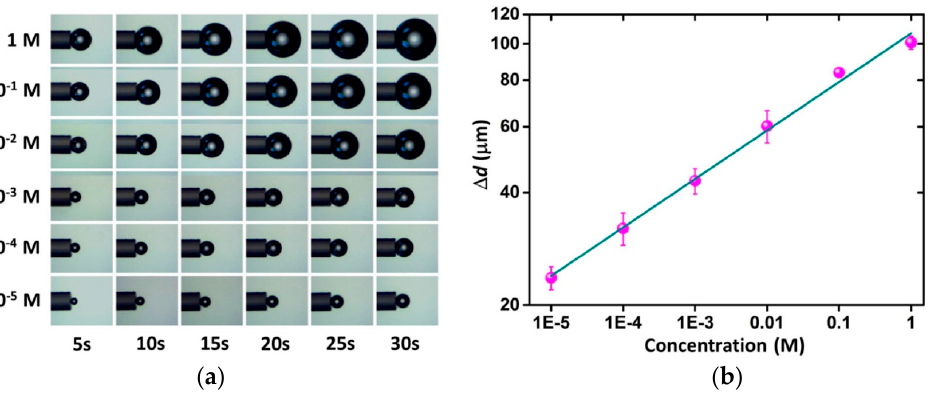
Figure 19. ( a ) Microscopic images of the microbubbles and ( b ) H 2 O 2 concentration detection [84].